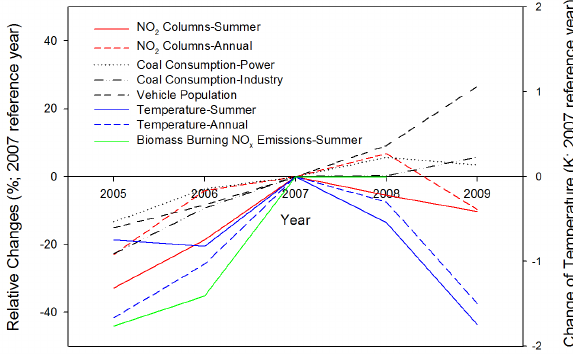
Fig. 9. Relative changes of annual and summer average OMI NO 2 columns, summertime biomass burning NO x emissions, and major annual anthropogenic activities, and absolute changes of annual and summer average temperature (2007 as reference year) during 2005– 2009 in Northeast China. Summertime biomass burning emissions were taken from the GFED database (van der Werf et al.,